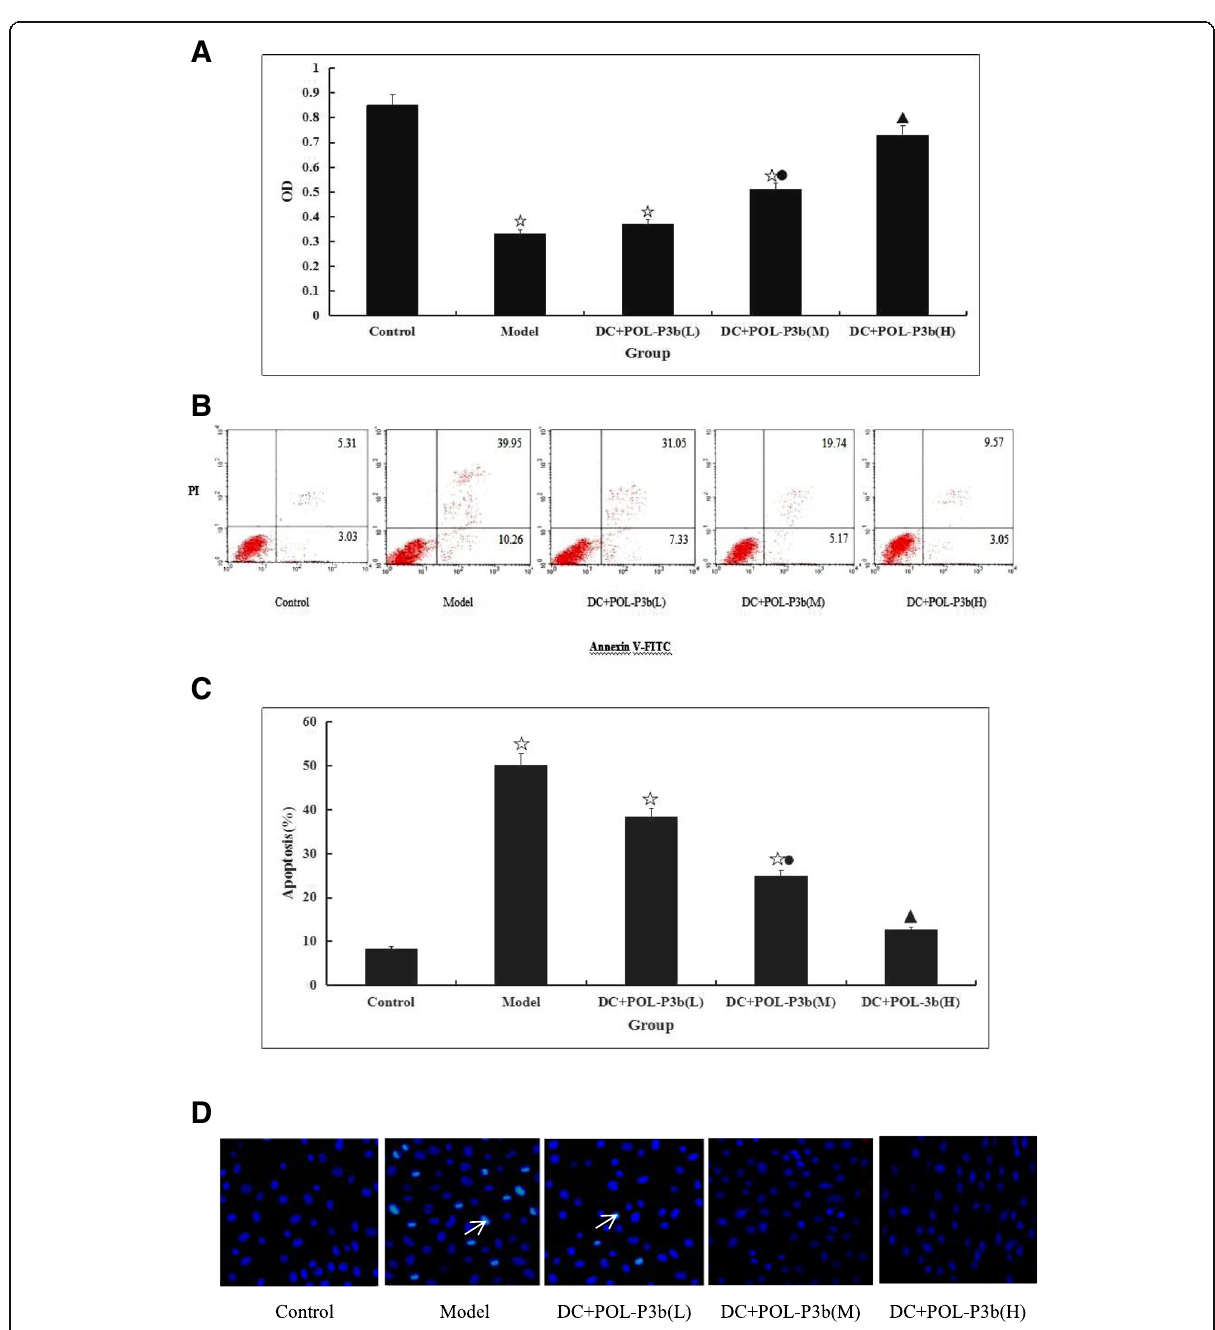
Fig. 1 POL-P3b induced the proliferation and inhibited apoptosis of intestinal DC by oral administration a The cell viability was evaluated by MTT assay. Data are mean values of triplicate assays ±SD, compared with control, ☆ P < 0.01; compared with model, ● P < 0.05, P < 0.01. b Annexin V- FITC/PI staining was used to analyze apoptosis. c Representative results and summative data from three independent experiments were shown. Each bar represents means ± SD ( n = 3). compared with control, ☆ P < 0.01; compared with model, ● P < 0.05, P < 0.01. d Intestinal DCs isolated from mice treated with POL-P3b (50 mg/kg,100mg/kg and 200 mg/kg, respectively) for 12 d were stained with Hoechst 33342